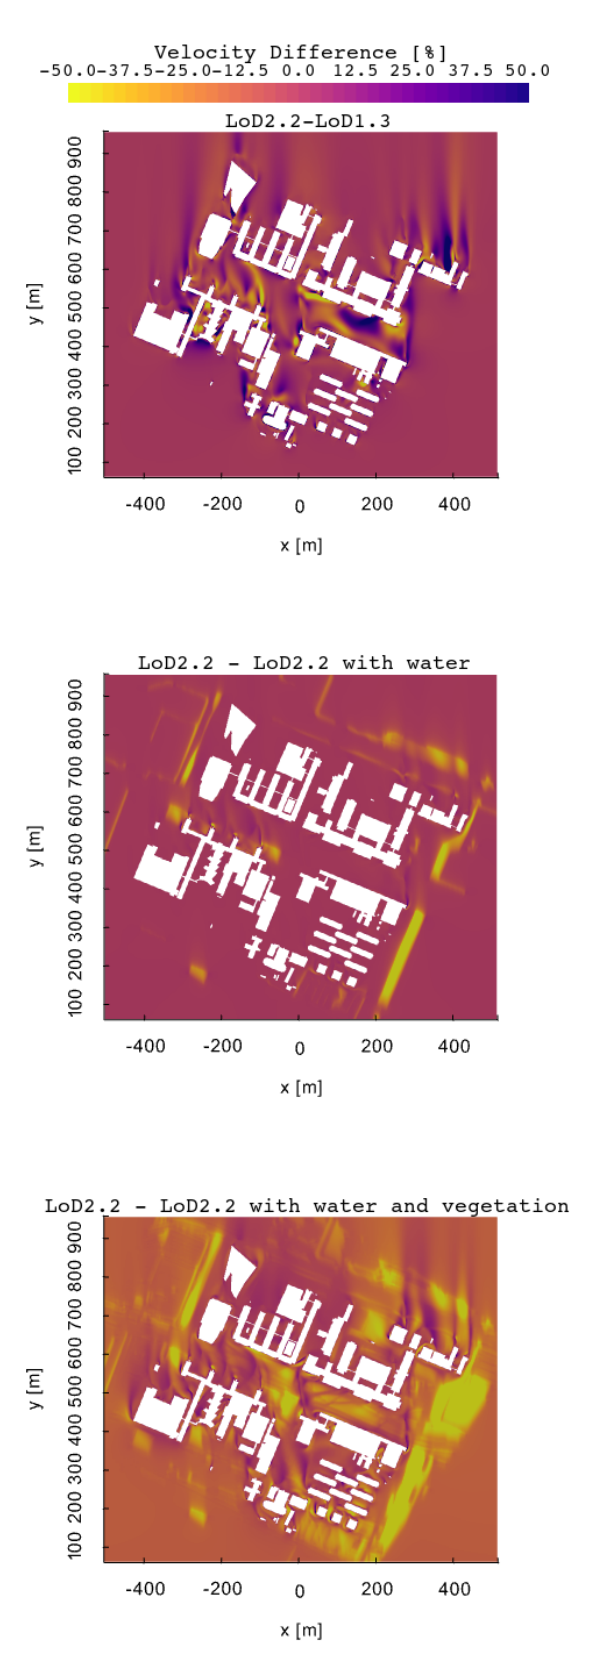
Figure 5. Velocity magnitude differences at 1.75 m height.